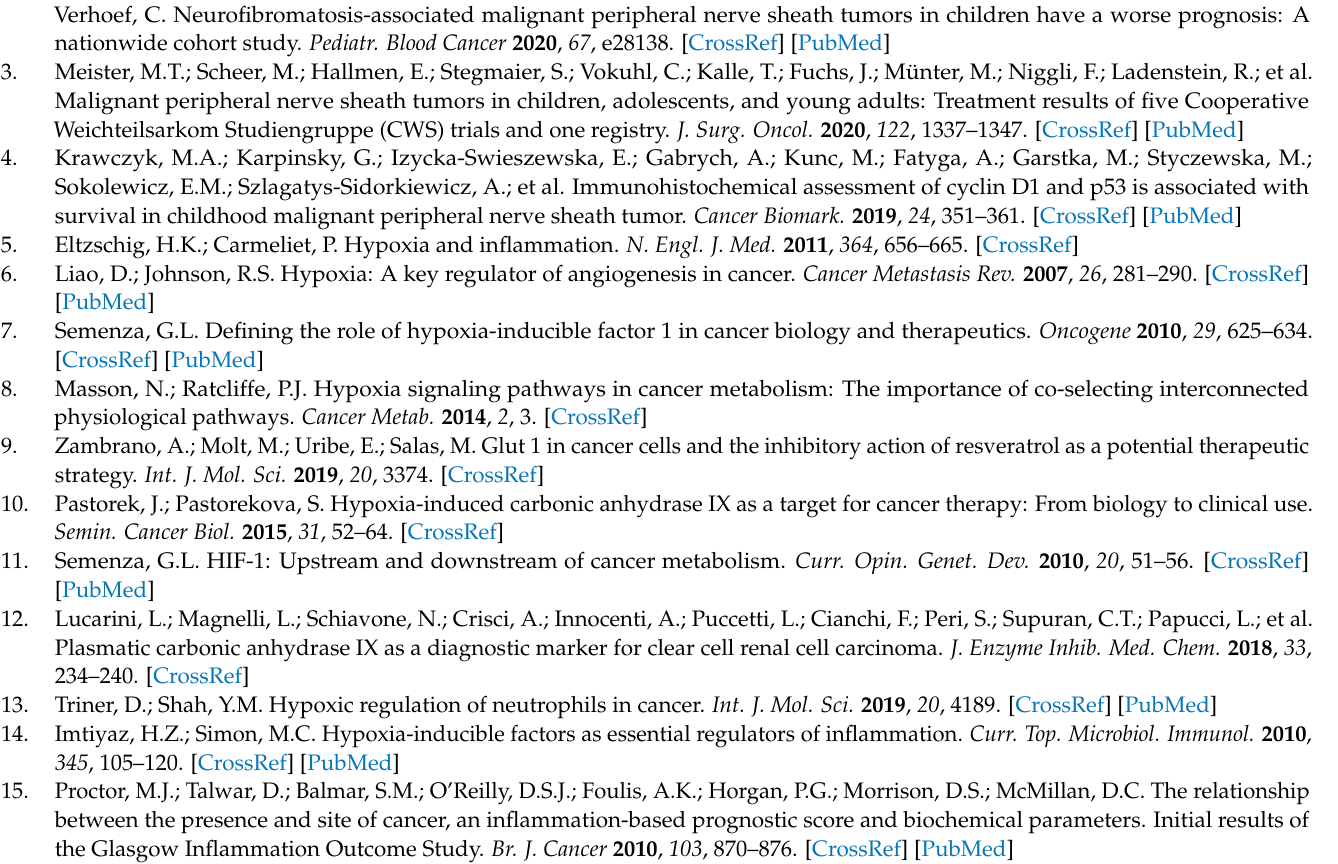
expression of hypoxic markers; Supplementary Figure S1, Kaplan–Meier curves plotted for overall survival (A–D) and relapse-free survival (E,F) for combinations of hypoxic and inflammatory